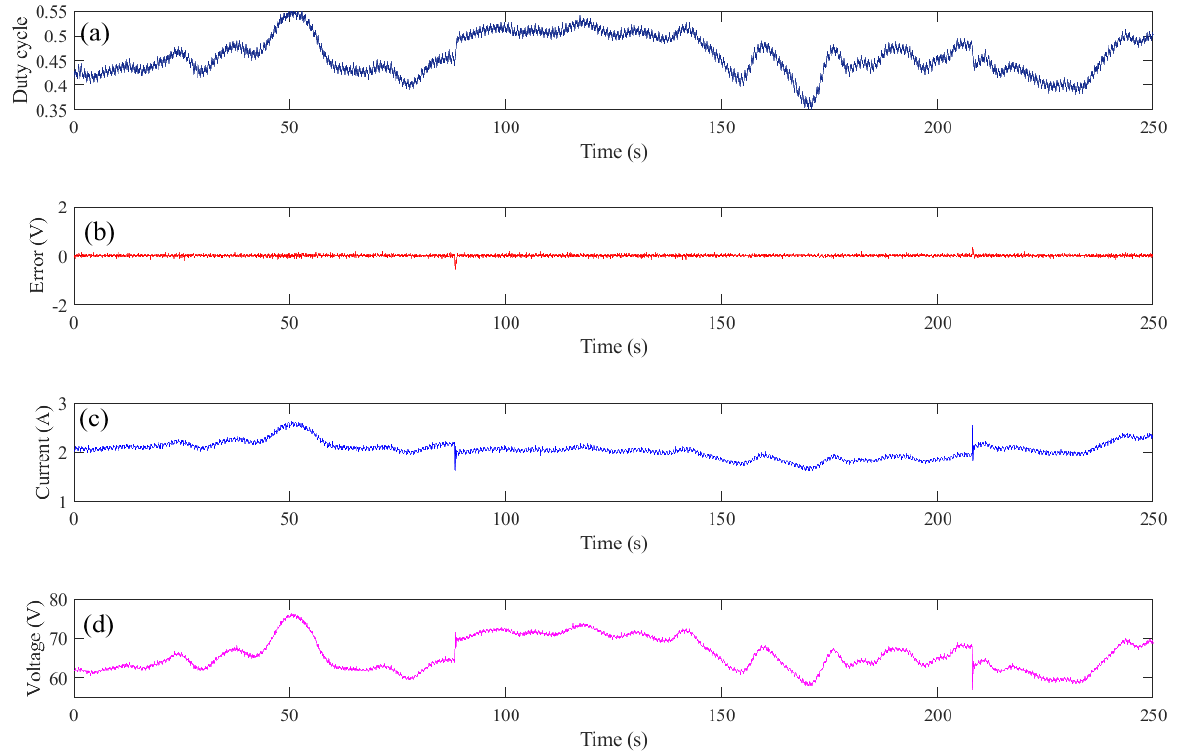
Figure 23. MPPT based on RNN and MPC: ( a ) Load Resistance ( V out / I out ); ( b ) PV current; ( c ) PV voltage; ( d ) PV power.